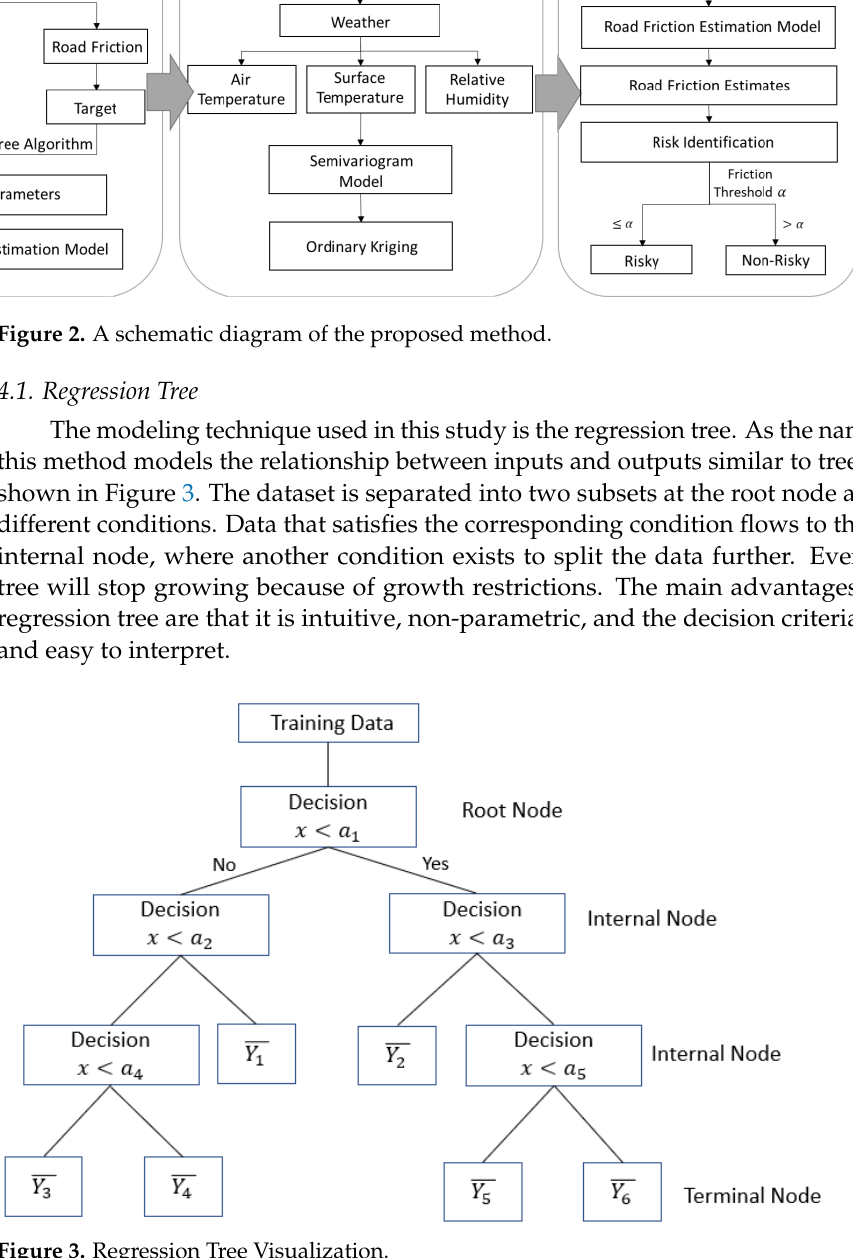
Figure 3. Regression Tree Visualization.